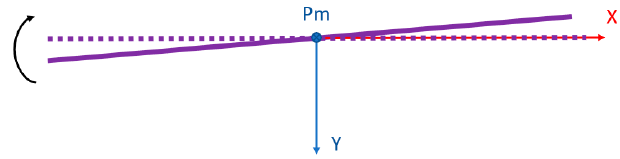
Figure 13. Visualization of flattening process.